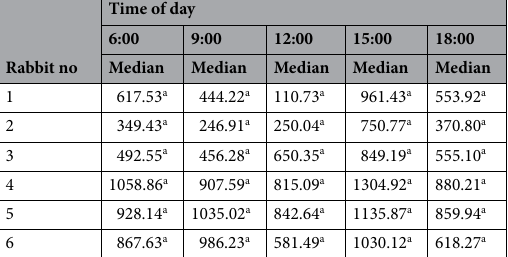
Table 1. Median concentrations of corticosterone (pg/ml) in the saliva of 6 rabbits at 6:00, 9:00, 12:00, 15:00, and 18:00. a The values in a column with the same superscript letter are not significantly different (p >